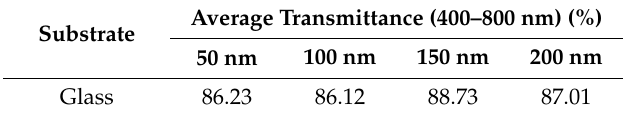
Table 2. Average transmittance of ITO films on the glass substrate with increasing ITO